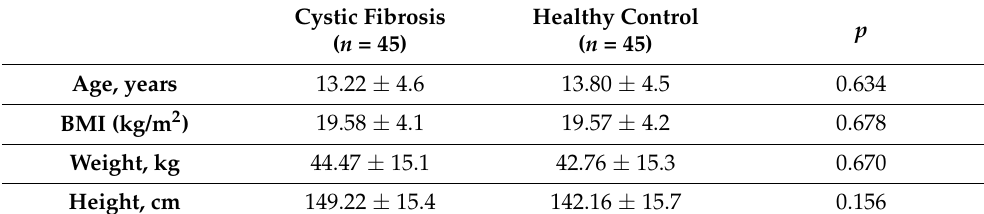
Table 1. Demographic characteristics of the study groups (pwCF and controls).